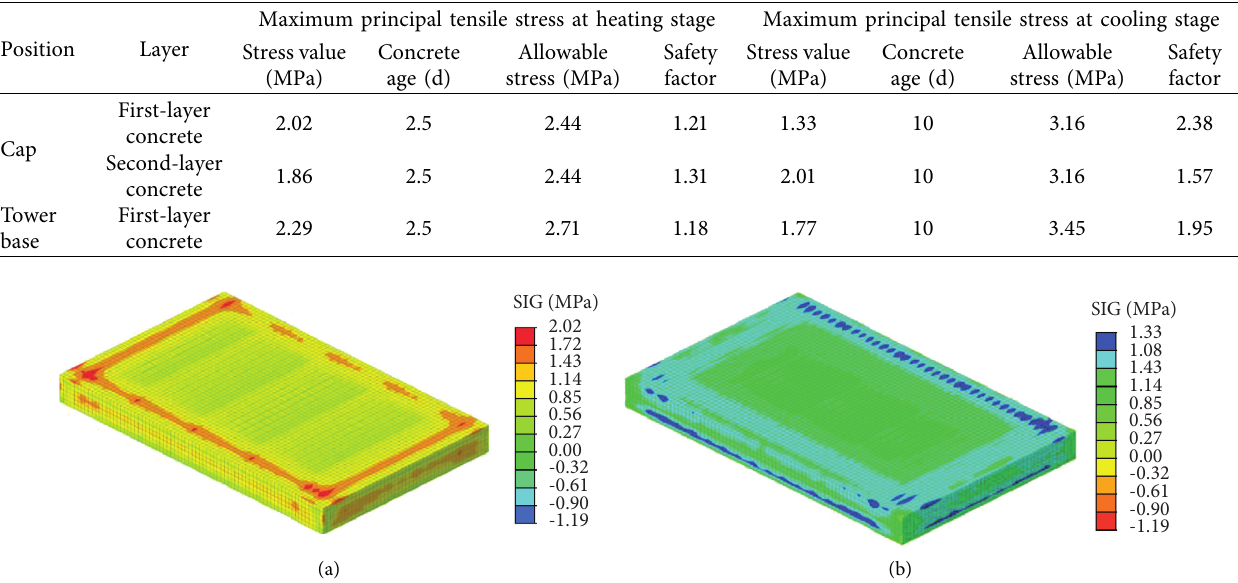
Figure 12: Cloud diagram of main tensile stress in the first layer of cap (unit: MPa). (a) Heating stage. (b) Cooling stage.